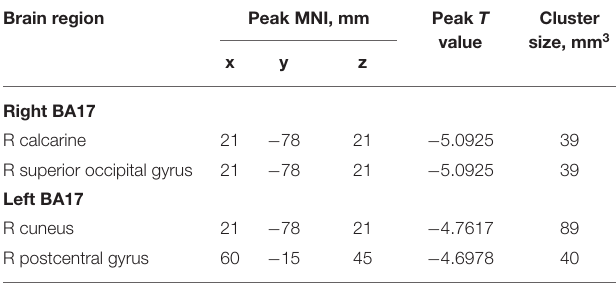
TABLE 2 | Regions revealing significant FC differences between IXT patients and HCs ( P < 0.05, corrected for GRF). Brain